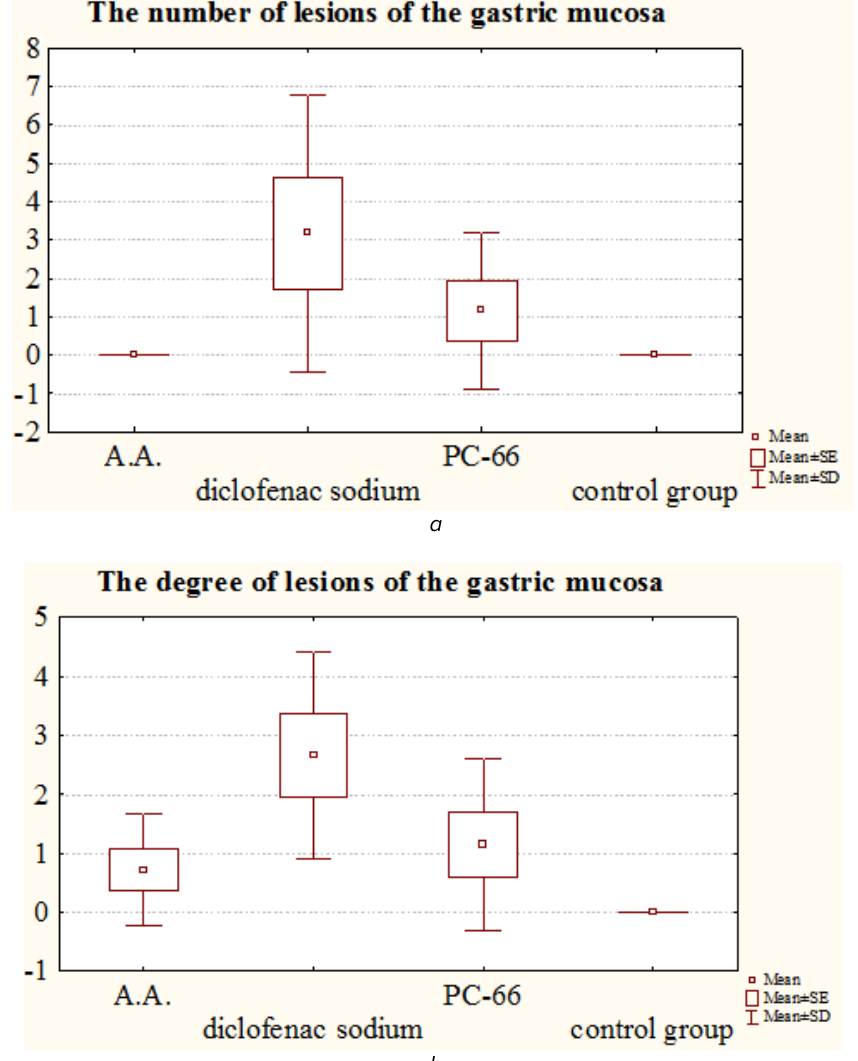
Fig. 2. Prevalence and severity of GM lesions during a 30-day administration of PC-66 and diclofenac sodium in rats with AA: a – prevalence; b –